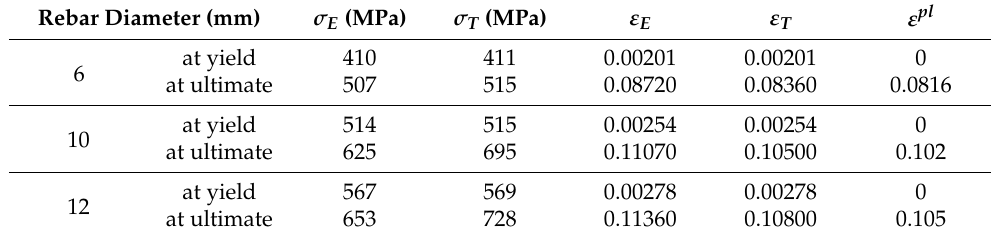
Table 5. Stress–strain conversions for reinforcing steel rebars. Rebar Diameter